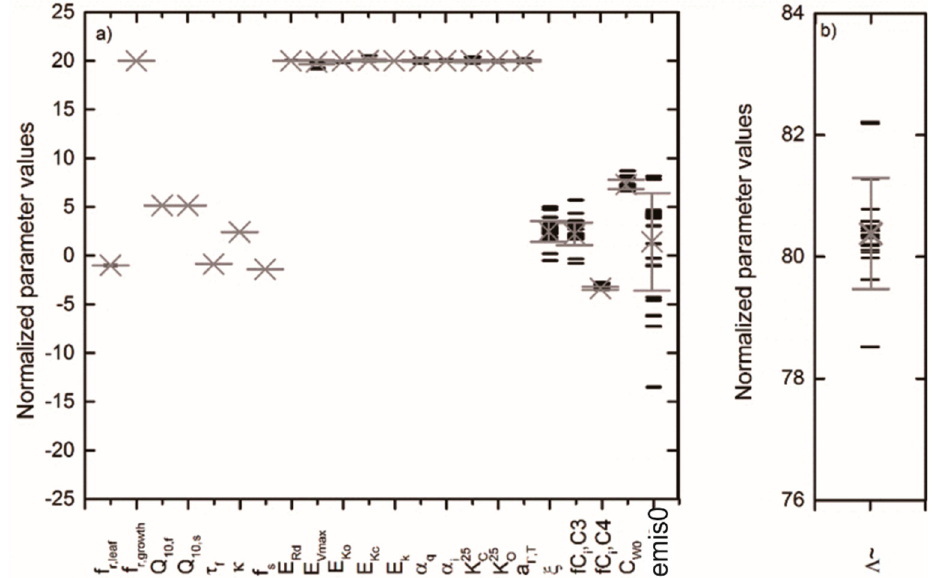
Figure 4. Posterior (i.e., optimized) values for global parameters in different assimilation experiments (bars). Values were normalized by prior uncertainty for representation in one figure ( a ); Λ ∼ is separately plotted in ( b ) due to its different range. Cross symbols denote the mean over all experiments and, error bars correspond to ± 1 standard